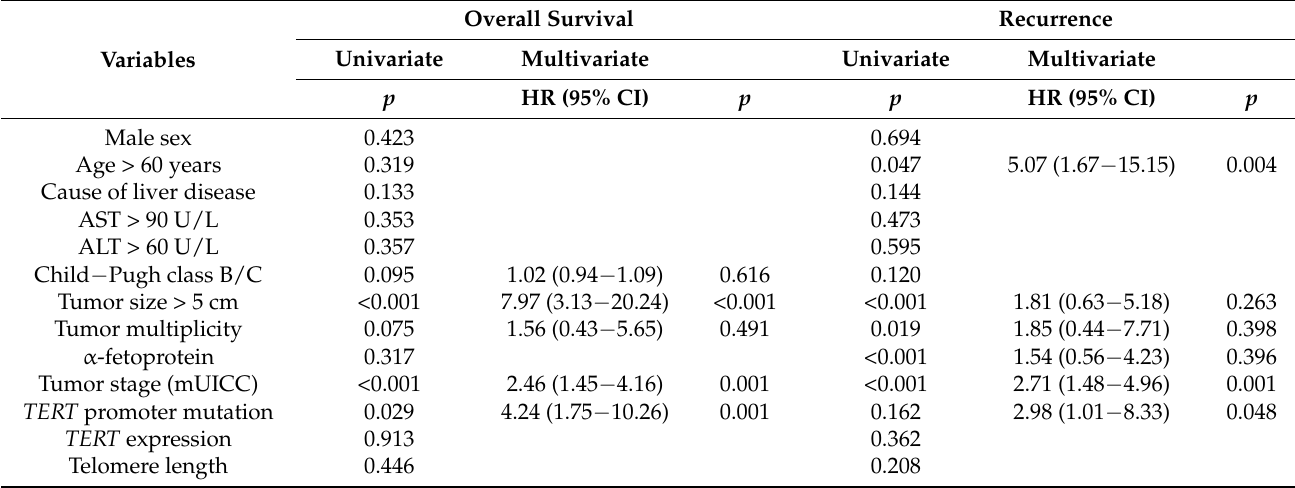
Table 2. Prognostic variables in patients undergoing hepatic resection.